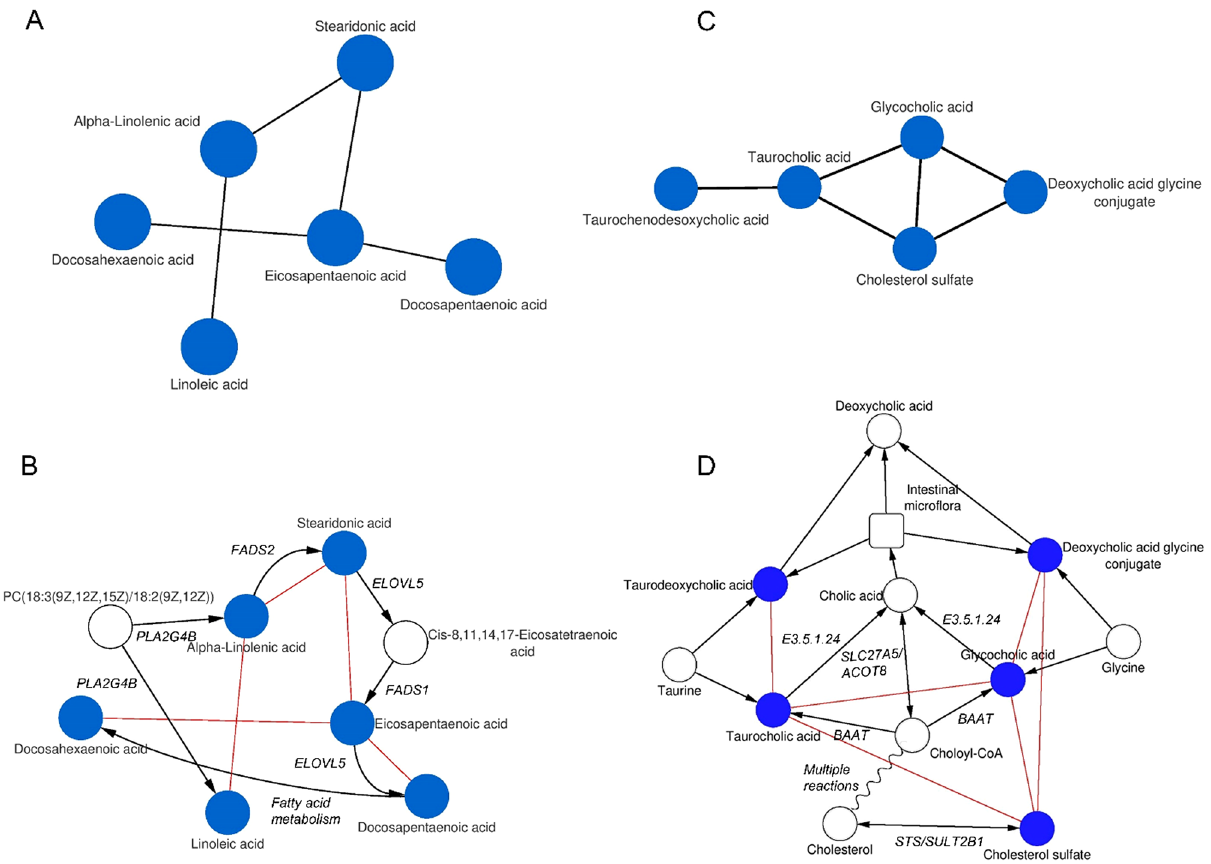
Figure 2. Linoleic acid ( A , B ) and bile acid metabolism ( C , D ) models inferred from GGMs of women FF and OW. ( A ) and ( C ) represent the sub-networks obtained from GGMs. ( B ) and ( D ) represent overlapping sub- networks of known biochemical reactions (black edges; labels correspond to regulating genes) obtained from KEGG pathway and from GGMs (red